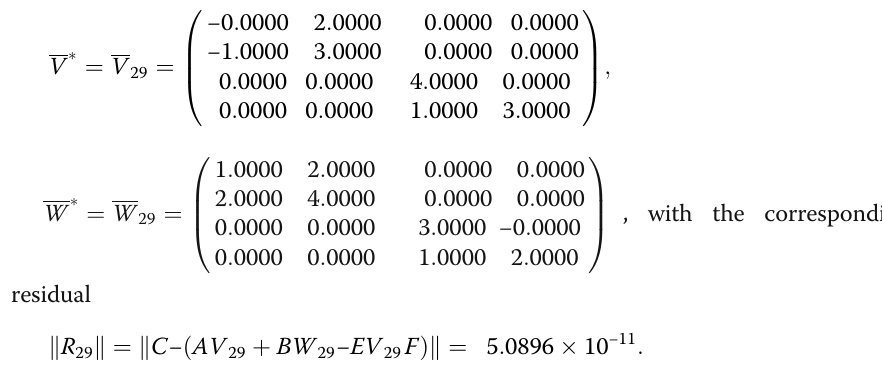
Table 2 indicates the number of iterations k and norm of the corresponding residual with V 1 ¼ W 1 ¼ 0 .